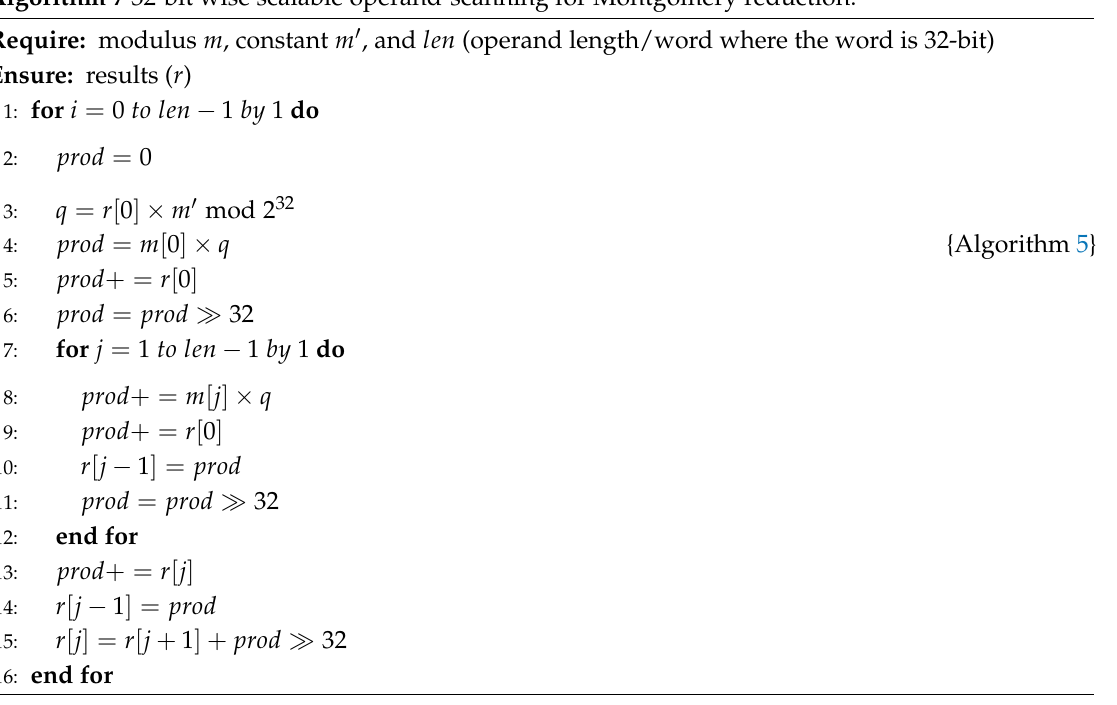
Algorithm 7 32-bit wise scalable operand-scanning for Montgomery reduction.